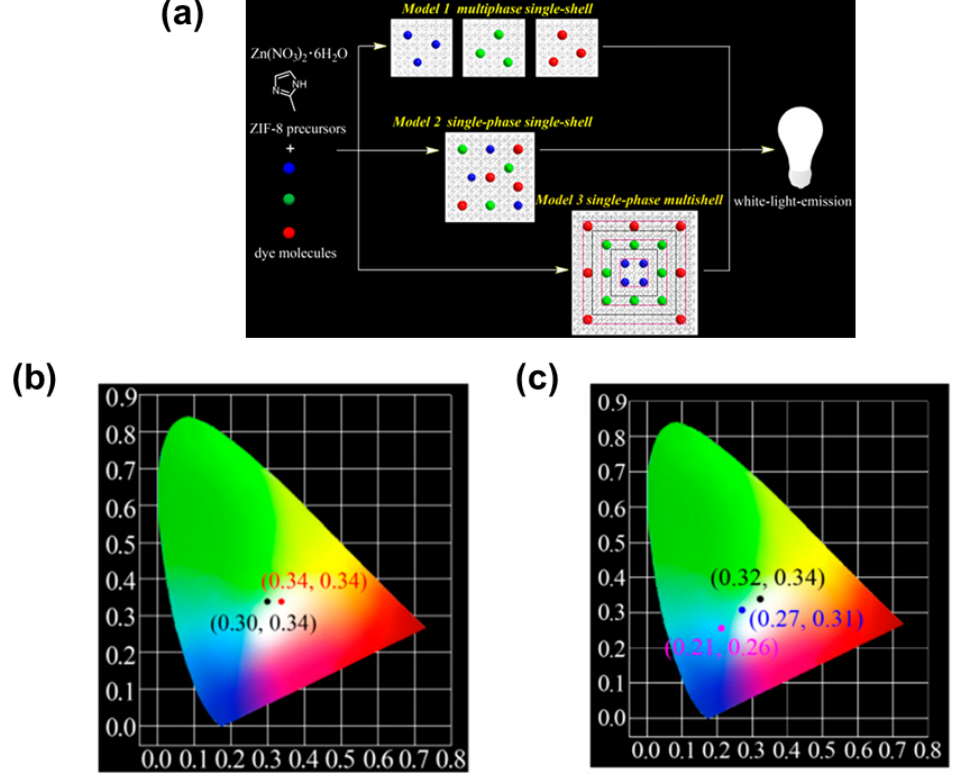
Figure 3. ( a ) Model 1 (multiphase single-shell dye@ZIF-8), Model 2 (single-phase single-shell dyes@ZIF-8), and Model 3 (single-phase multi-shell dyes@ZIF-8); ( b ) CIE coordinates of C- 151&F&RB@ZIF-8 2 with different concentrations of dyes at λ ex = 365 nm; ( c ) CIE chromaticity coor- with permission from ref. [44]. Copyright © 2019, American Chemical Society).